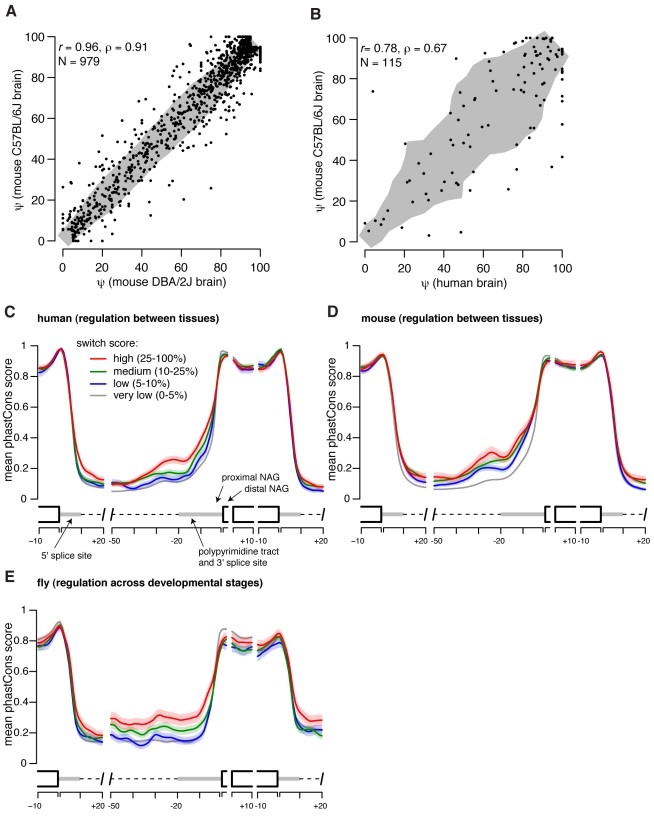
Increased sequence conservation upstream of tissue- and developmentally-regulated NAGNAGs.(A) NAGNAG ψ estimates are highly consistent in brain RNA-Seq data from the mouse strains DBA/2J and C57BL/6J. Only NAGNAGs with both isoforms expressed at ≥5% in either strain are shown. The 75th percentile of the deviation from the line y = x is shown in gray. (B) NAGNAG ψ estimates are quantitatively conserved between human and mouse brain. Only NAGNAGs with both isoforms expressed at ≥5% in either species and satisfying |proximal 3′ splice site score – distal 3′ splice site score|≤0.5 bits are plotted (splice sites scored by MaxEnt model [36]). Deviation from y = x shown as in (A). (C) Sequence conservation of human NAGNAGs, where all NAGNAGs are aligned by their 3′ splice site junctions and grouped by switch score. Mean (solid line) and standard error of the mean (shaded area about solid line) of phastCons score [50] shown by position (averaged over a 2 nt sliding window) for each switch score category. Analysis restricted to human NAGNAGs for which the two AGs were conserved at the sequence level in mouse. (D) As in (C), but grouped by switch score in mouse and restricted to mouse NAGNAGs for which the two AGs were conserved at the sequence level in human. (E) As in (D), but for NAGNAGs in Drosophila melanogaster, with switch score defined across developmental stages rather than between tissues. Analysis restricted to D. melanogaster NAGNAGs for which the two AGs were conserved at the sequence level in D. yakuba.